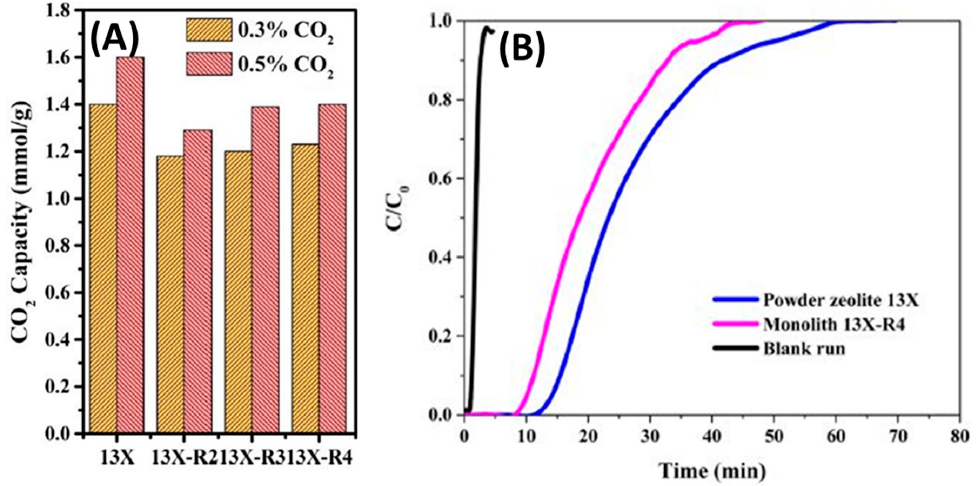
Figure 15. ( A ) CO 2 adsorption capacities for 3D-printed monoliths and zeolite powders obtained at 25 °C using 0.3% and 0.5% CO 2 in N 2 . ( B ) Breakthrough curves for 13X-R4 and 3D-printed monoliths and zeolite powders obtained at 25 °C and 1 bar. Reproduced with permission from [65]. Copyright American Chemical Society, 2016.